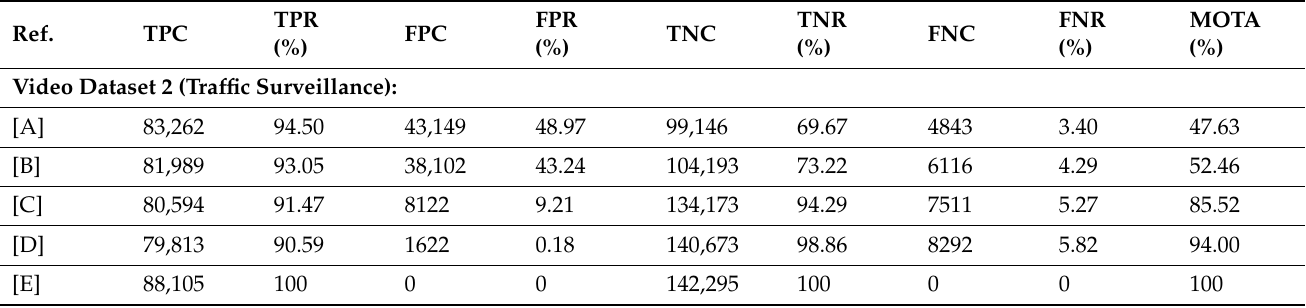
Table 2. Comparison of performance parameters by different approaches tested on video dataset 2: [A] by Pan et al. in [12]; [B] by Mehboob et al. in [13]; [C] by Indu, S. in [14]; [D] our proposed approach; [E] the true data obtained using markers.